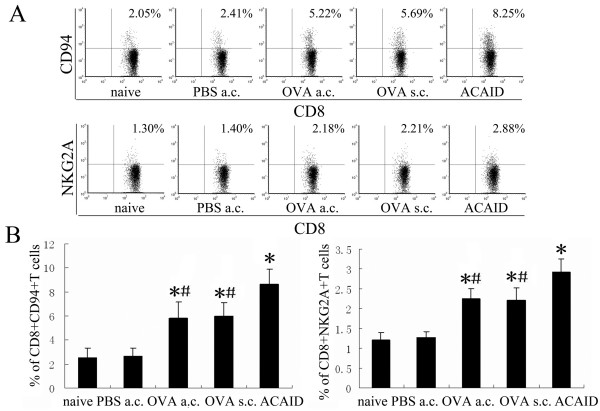
Expression of CD94-NKG2A protein on CD8+T cells. Mice underwent various treatments and were divided into naïve group, PBS-AC-injected group, OVA-AC-injected group, immunized group and ACAID group. A: Splenic MNC were harvested from each group and stained with anti-CD3, anti-CD8, anti-CD94 and anti-NKG2A mAb, then the CD3+CD8+T population was gated and analyzed for the expression of CD94 and NKG2A protein. B: FCM histogram showed the frequencies of CD8+CD94+T and CD8+NKG2A+T cells among CD8+T cells. Results represent the mean ± SEM of three separate experiments. *p < 0.05 compared with naïve mice. #p < 0.05 compared with ACAID mice.